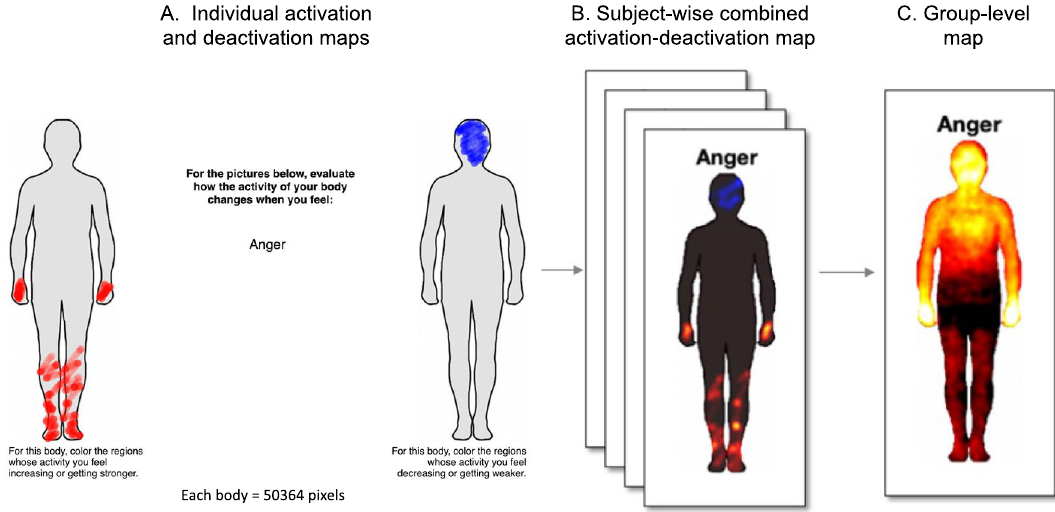
Figure 1. emBODY tool. ( A ) Representation of a single trial showing individual activations and deactivation maps for Anger. ( B ) The subject-wise analysis involves merging individual activation and deactivation maps into a single image and smoothing. Images preprocessed that way undergo visual inspection. ( C ) Finally, individual images are subjected to a one-sample t-test to produce group-level maps. These maps are used in subsequent analyses.